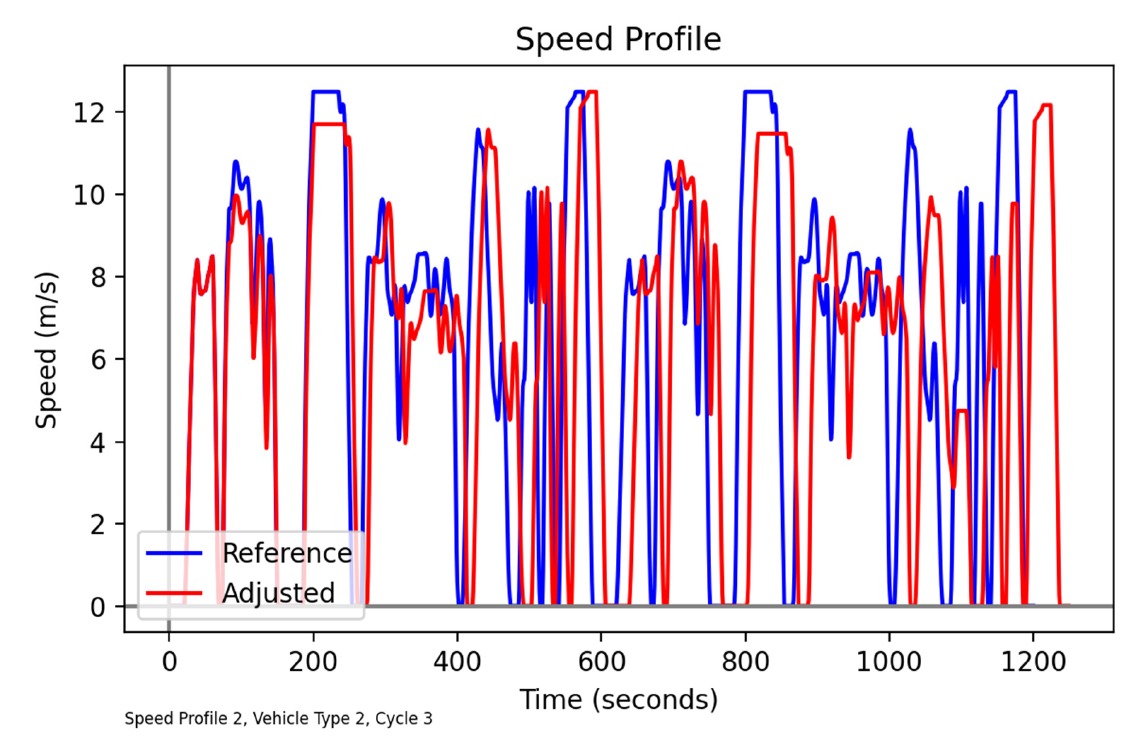
Figure 15. Reference and adjusted speed profiles for the Lisbon case.